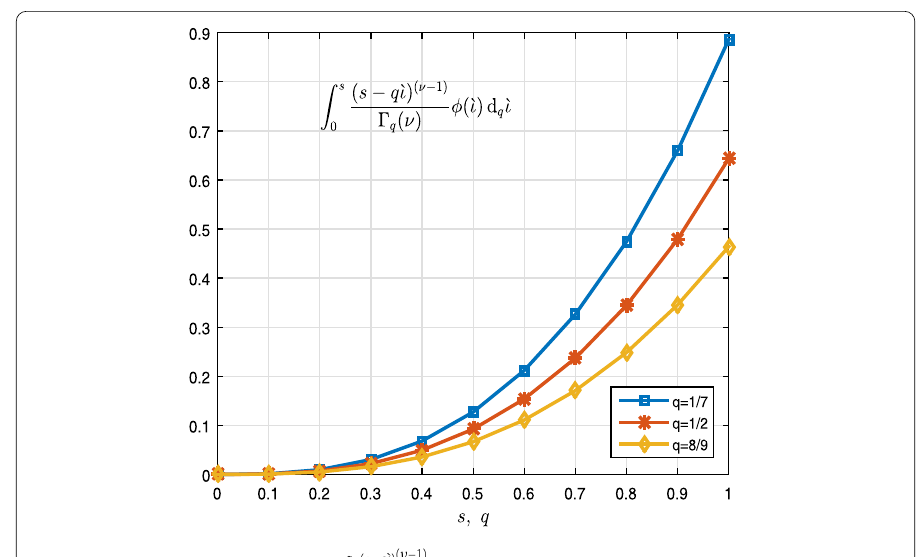
Figure 5 Graphical representation of